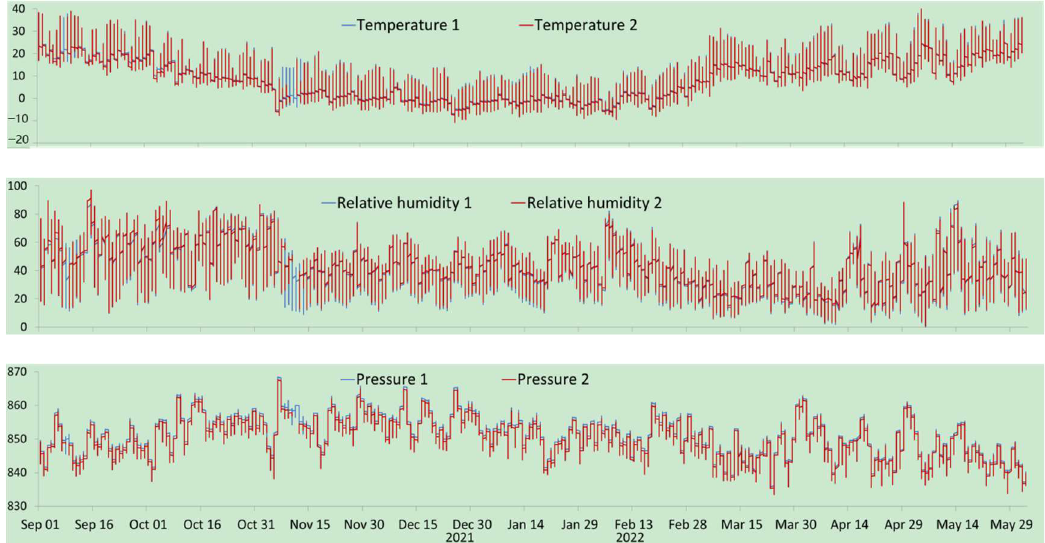
Figure 9. Real-time monitoring data for temperature (°C, top ), relative humidity (%, middle ), and pressure (hpa, bottom ) from the monitoring system from 1 September 2021.